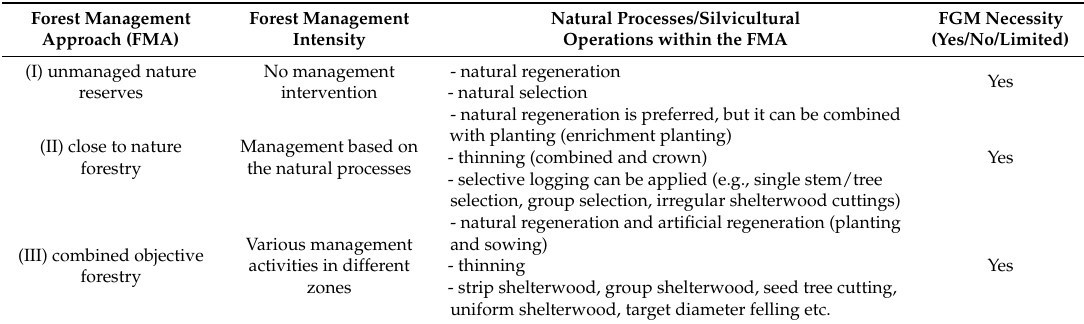
Table 1. Overview of Forest Management Approaches (FMAs) by Duncker et al. [43] and silvicultural operations linked to the need for